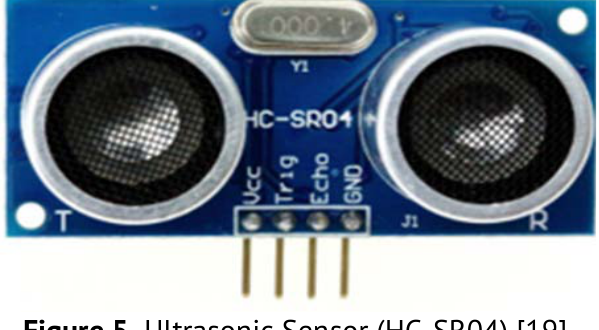
Figure 5. Ultrasonic Sensor (HC - SR04)